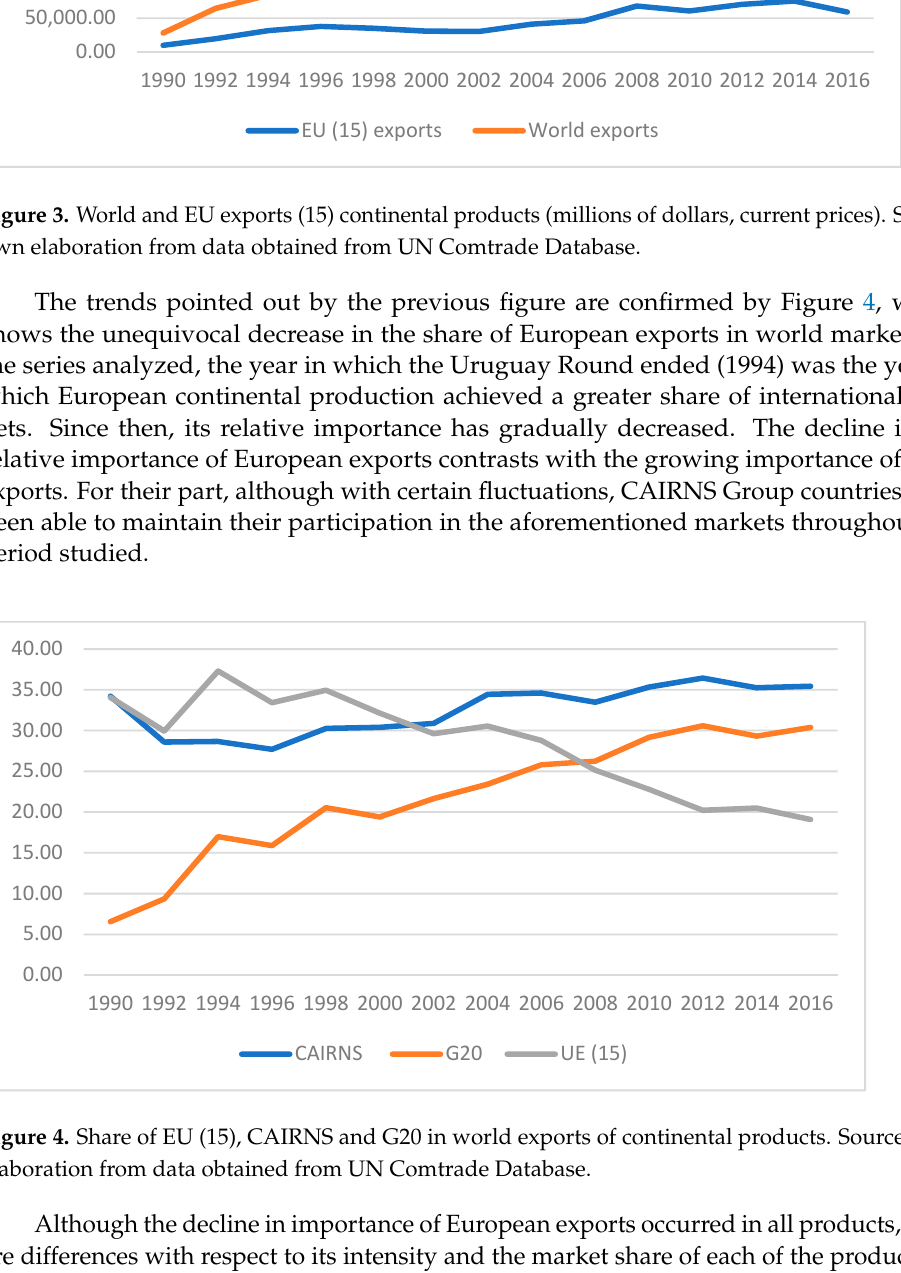
Figure 5. European share in world exports of continental products. Source: own elaboration from data obtained from UN Comtrade Database. 4.2. Foreign Trade Balance of Continental Agricultural Products As shown in Figure 6, in the recent evolution of the foreign trade balance of the continental products, it is possible to differentiate two periods. In a first stage (1988– 2000), there were no significant changes in the trends of imports and exports, while in a second period (2000–2016), the trade deficit increased due to the increase in imports. This fact inevitably relates to the stagnation of European production since the mid-1990s (Figure 2). Despite the fact that, in the mid-2000s, as a consequence of the growth in world demand, European exports also enjoyed an appreciable increase, this was not